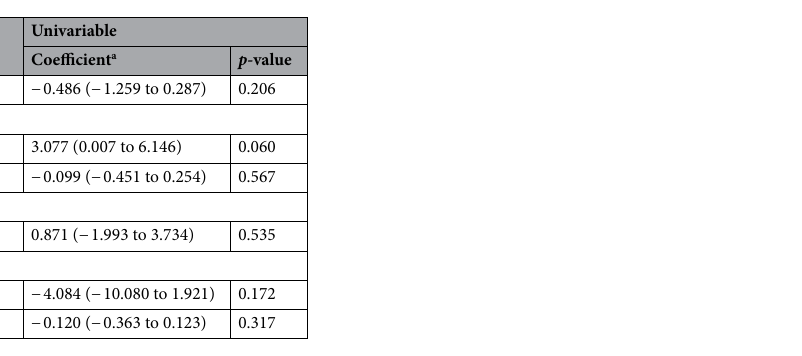
Table 3. Linear regression analysis of leg length discrepancy in patients with mild slip. CI confidence interval. a The values are given as coefficients, with the 95% CI in parentheses.